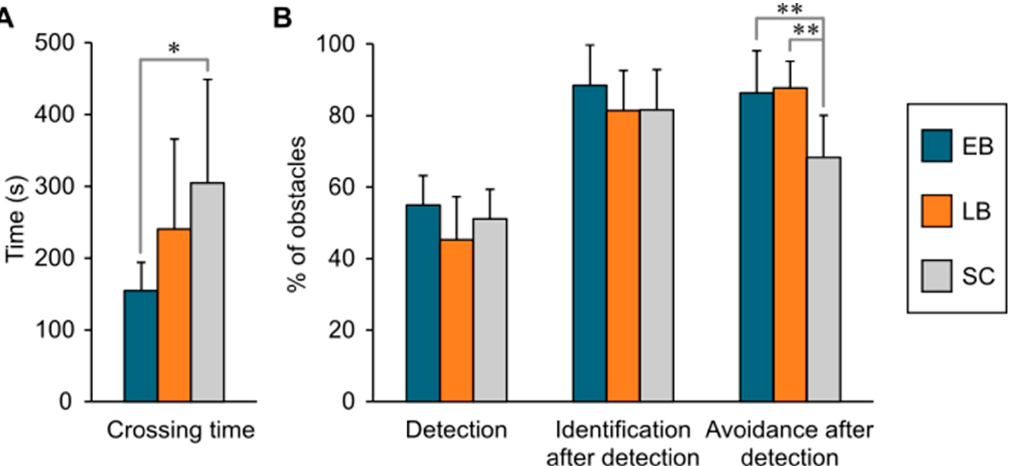
Figure 3. The average crossing time ( A ), and the mean rates of detection, identification, and avoidance by the three subject groups ( B ). Significant differences are indicated by asterisks (* = p < 0.05; ** = p < 0.01). EB = early blind; LB = late blind; and SC = sighted control.